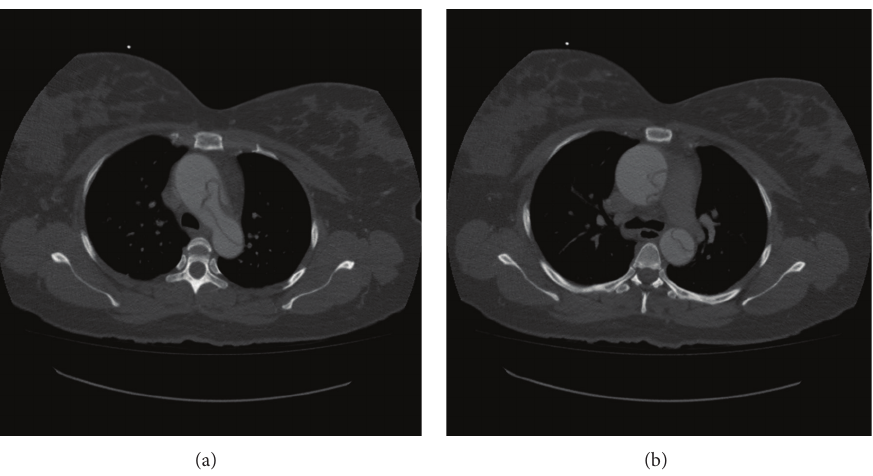
Figure 1: Axial view demonstrating acute dissection in ascending and descending aorta.